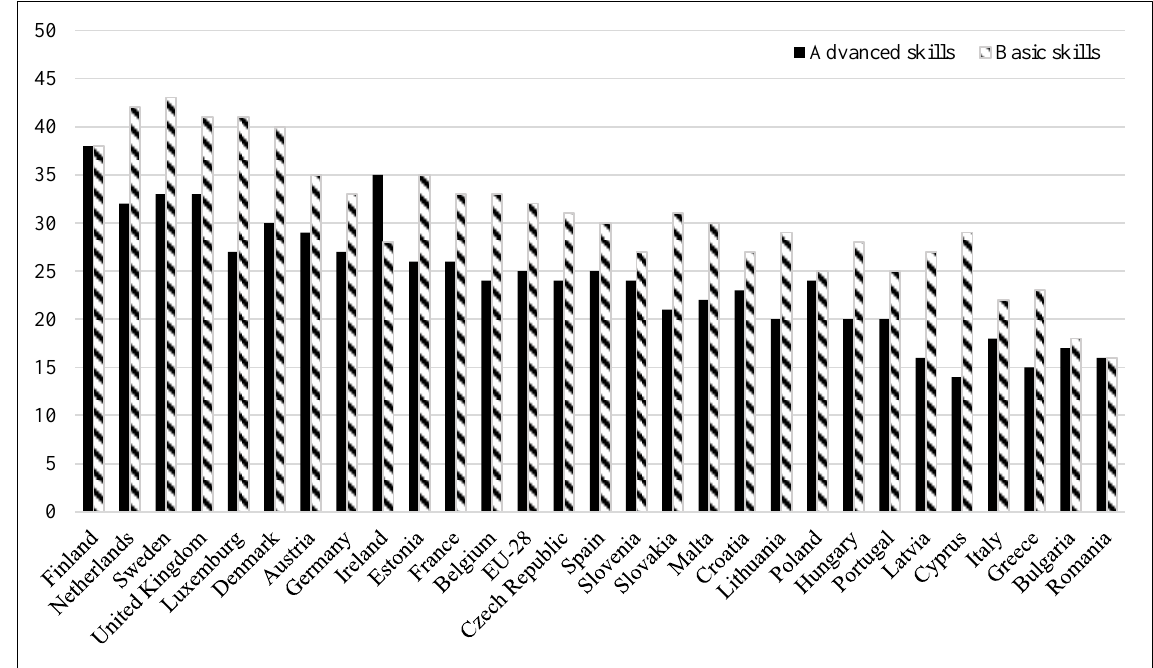
Figure 3. Advanced vs. basic human capital skills in the European Union Member States, DESI